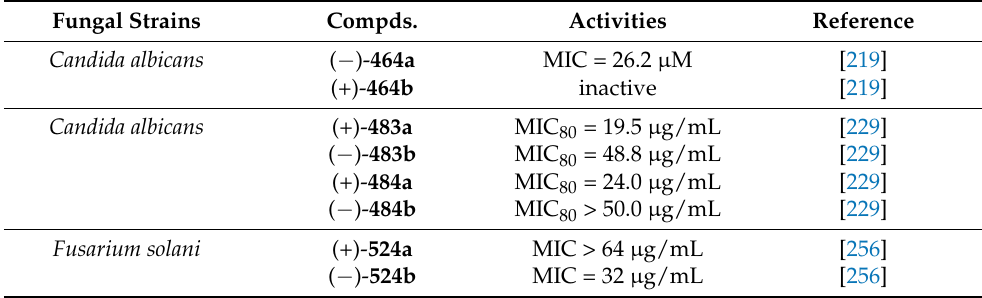
Table 5. Antifungal activities of